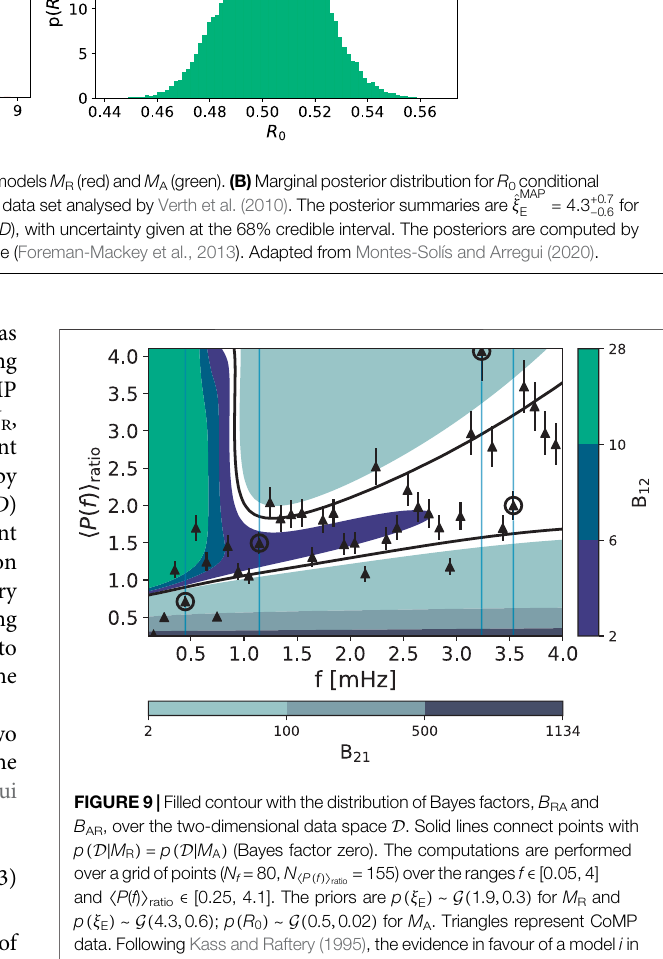
Figure 9 are observed CoMP data with assumed error bars.